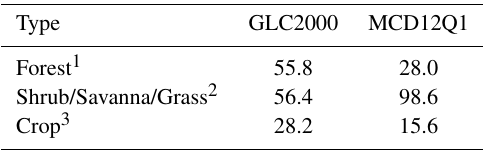
Table 2. Global area totals (10 6 km 2 ) for forest, shrub/savanna/- grass, and crop land in GLC2000 and